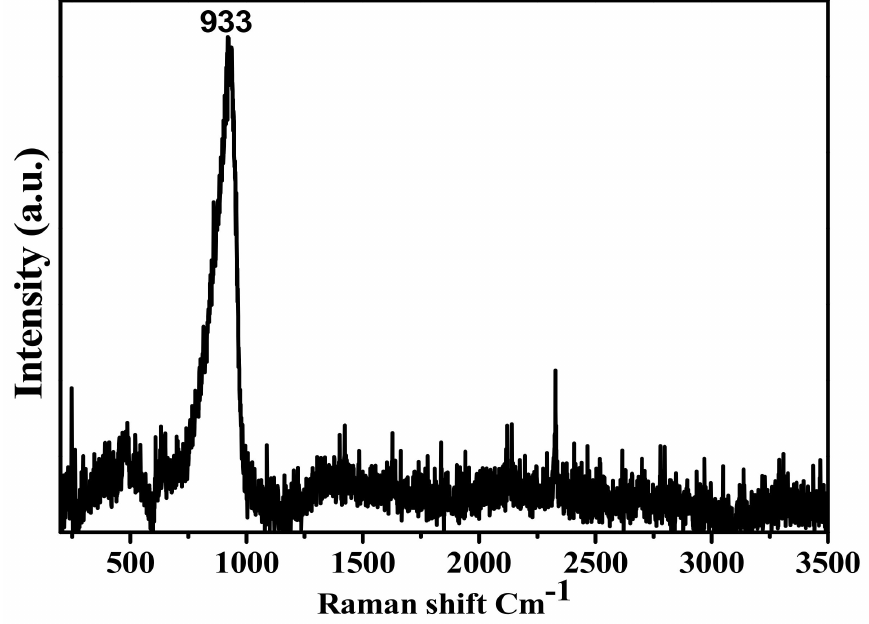
Figure 2. Raman analysis of MoO 3 thin